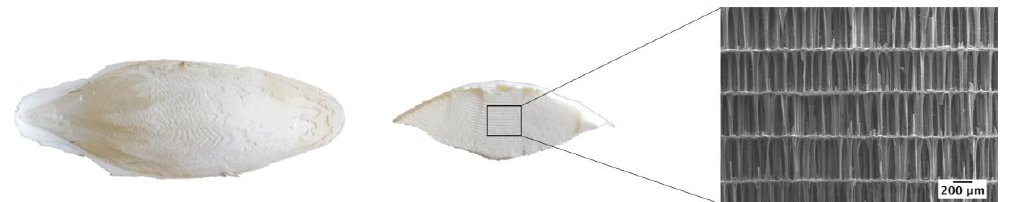
Figure 5. CB bone, its tranverse section and the scanning electron microscopy of the dorsal shield and the lamellar matrix. the lamellar